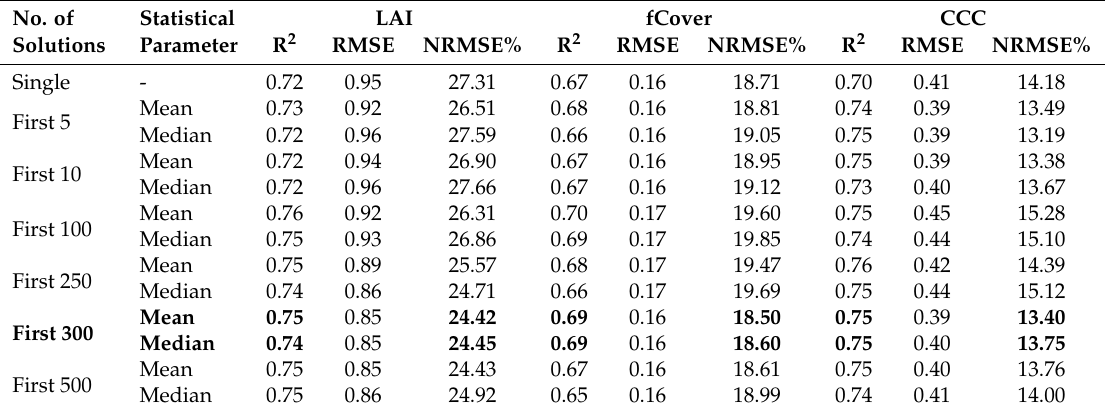
Table 6. Retrieved parameters from LUTreg for single and multiple